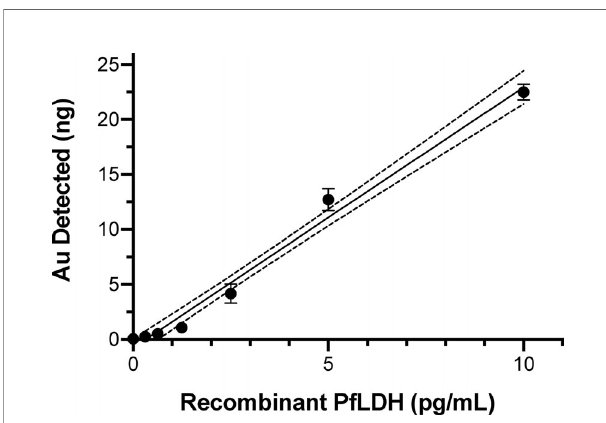
FIGURE 2 | ICP-MS immunoassay results showing the elemental gold signal levels from known amounts of recombinant PfLDH protein. PfLDH was captured by the primary mAb from 30 µl volumes of the indicated concentrations of PfLDH. After binding of AuNP-labeled detection mAb and analysis by ICP-MS, the elemental gold levels were used to calculate the linear best- fi t calibration line (solid line) and 95% con fi dence intervals (dotted lines). Average values with standard errors are shown. All experiments were performed in